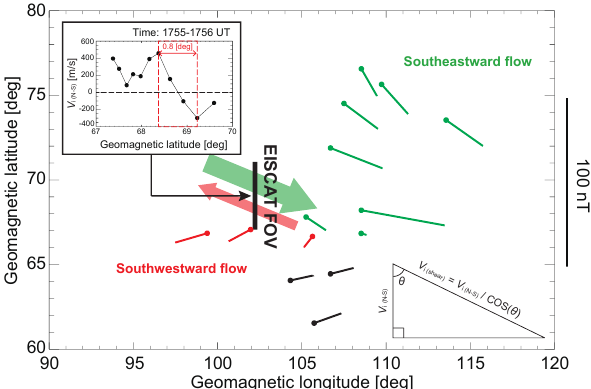
Figure 4. The horizontal distribution of the convection vectors at ∼ 17:55UT. The green, red, and black vectors are the convection vectors from the IMAGE magnetometer. The large red arrow indi- cates the localized northwestward flow, which was assumed from the horizontal distribution of the convection vector and EISCAT data. The line plot shows the latitudinal variation of the V i ( N − S ) at ∼